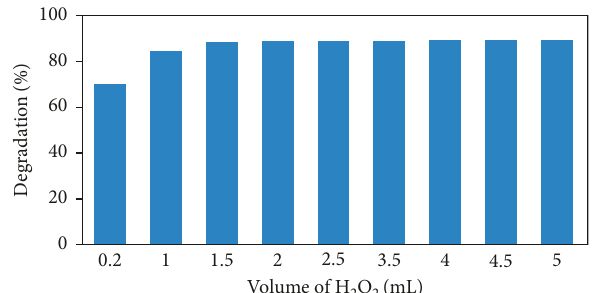
Figure 7: Effect of the hydrogen peroxide concentration on the degradation percentage of